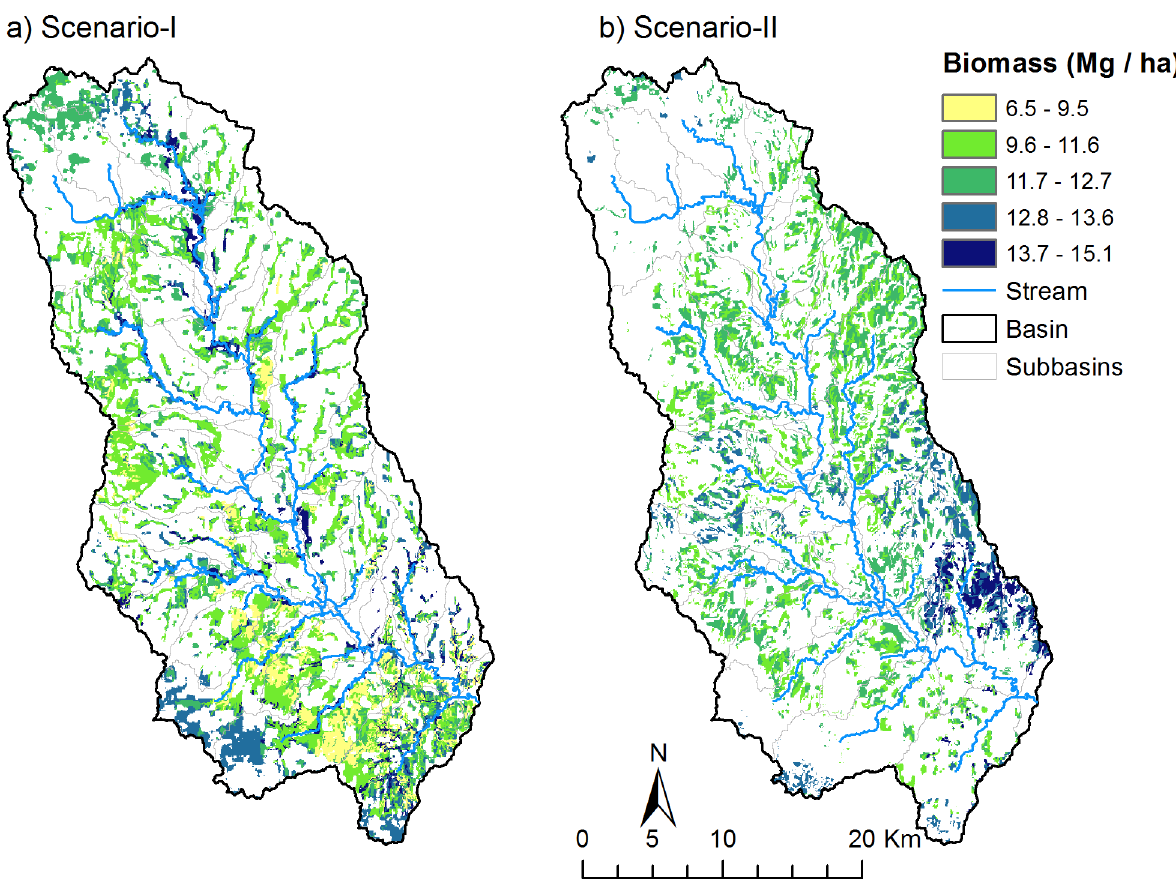
Fig 4. Simulatedaverageannualswitchgrassproductionfor 2002–2011 for conversionof grasslands (a) and marginalcroplands(b) to switchgrass.